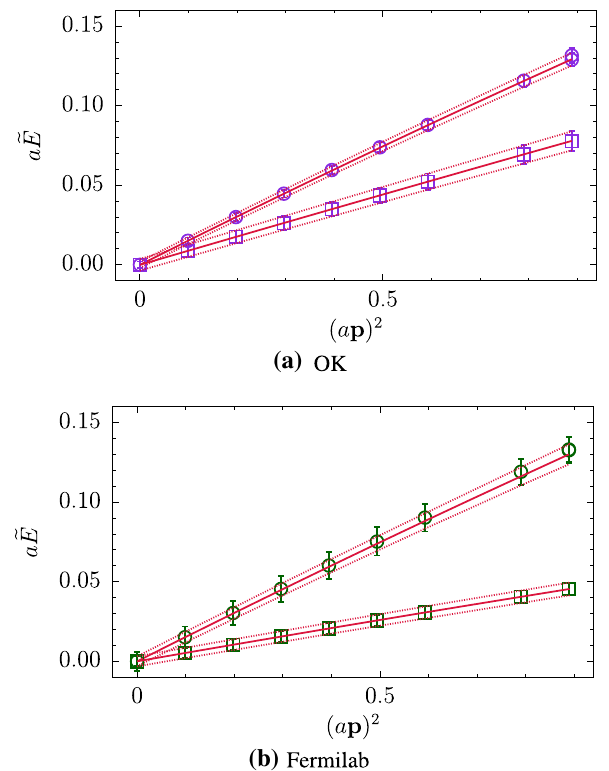
Fig. 3 The pseudoscalar heavy–light meson (circle) and quarkonium (square)subtractedenergies (cid:16) E [Eq.(34)]asafunctionof ( a p ) 2 for a the OKactionat κ = 0 . 041and b theFermilab(clover)actionat κ = 0 . 083. The lines show fits to Eq. (30). The errors are from a single-elimination jackknife. In these plots, the errors for the bottomonium data points and fit lines are scaled by a factor 10. The behavior for vector mesons is similar, apart from the larger statistical